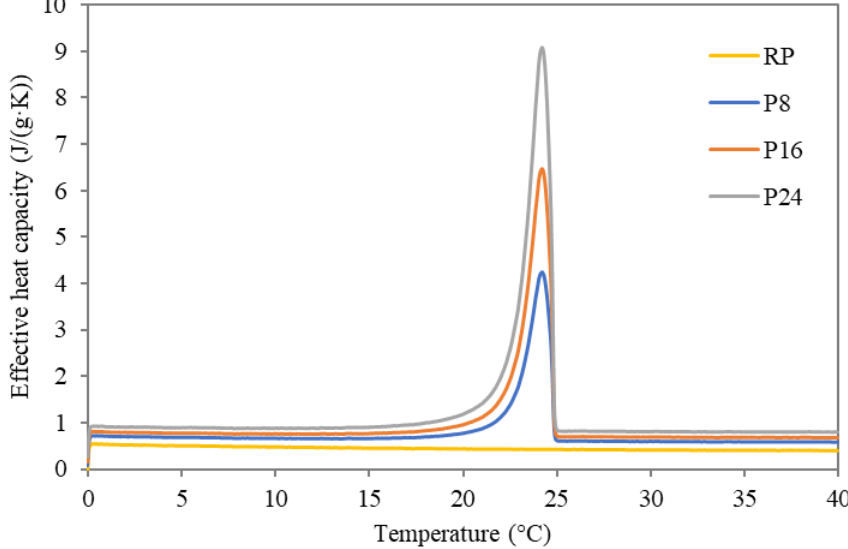
Figure 4. Temperature dependent effective heat capacity of studied FSPCM plasters during heating. Table 5. Phase change temperatures of studied plasters and specific enthalpies.